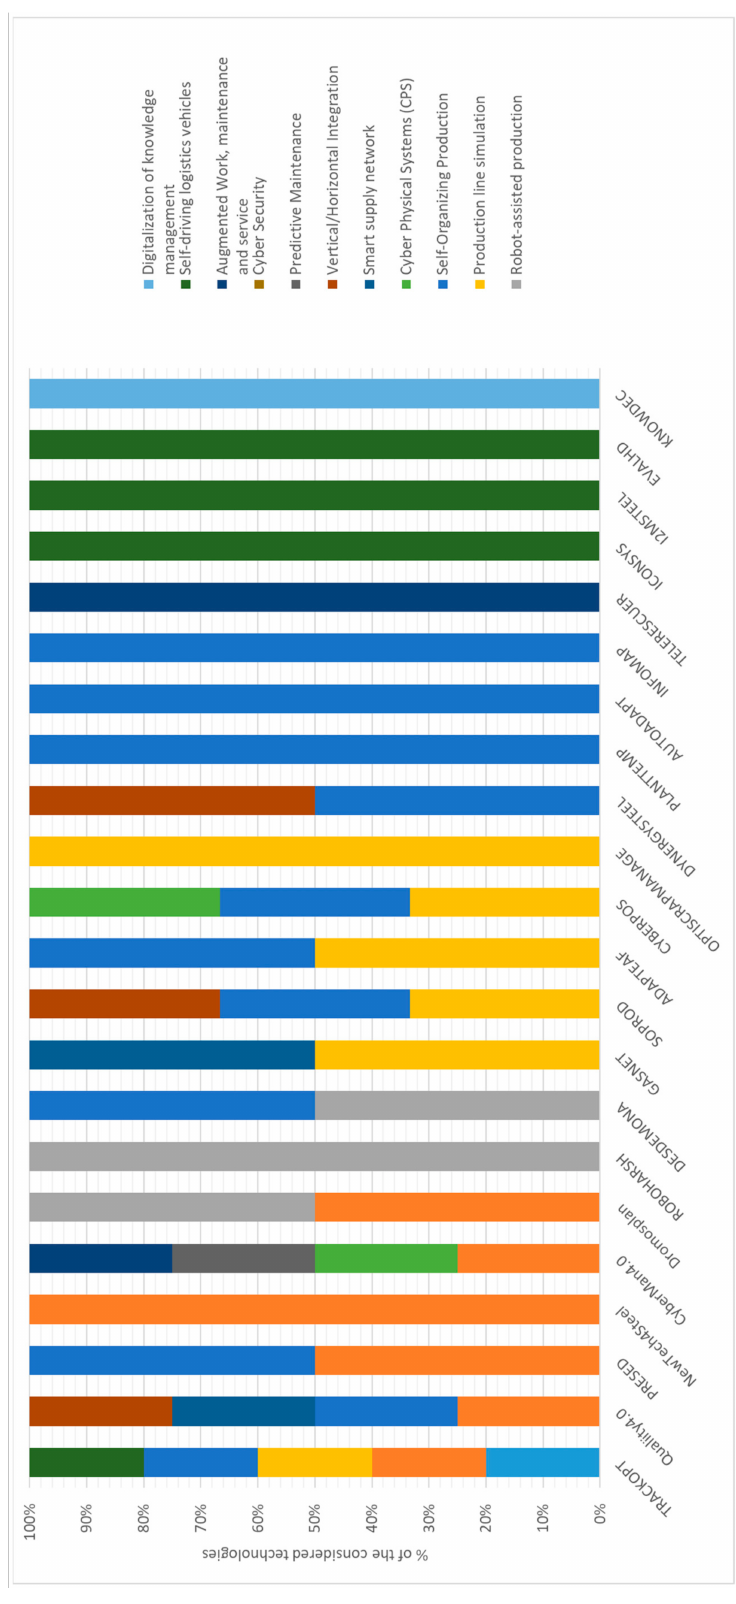
Figure 1. Research Fund for Coal and Steel (RFCS) Projects and the developed enabling